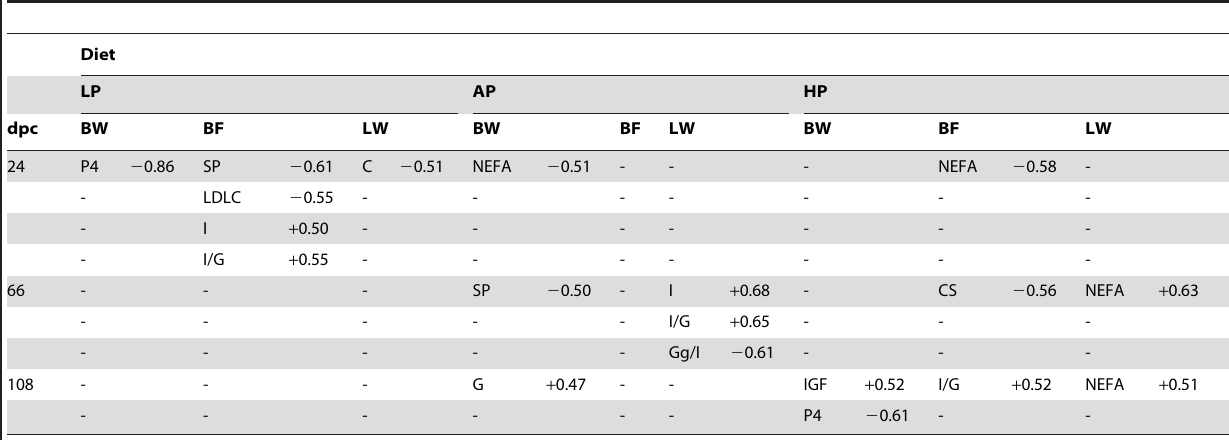
Table 6. Significant Pearson correlation coefficients within diets and day after insemination between plasma metabolite and hormone concentrations and sow BW, sow BF as well as pregnancy outcome (total litter weight at birth,